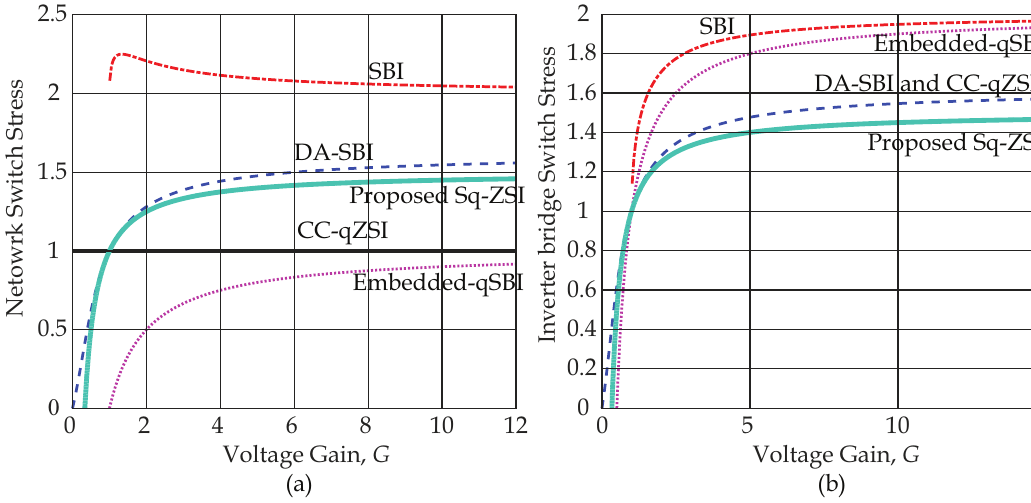
Figure 8. Switch stress comparison among the selected topologies with various voltage gains: ( a ) network switch stress comparison, and ( b ) inverter bridge switch stress comparison.